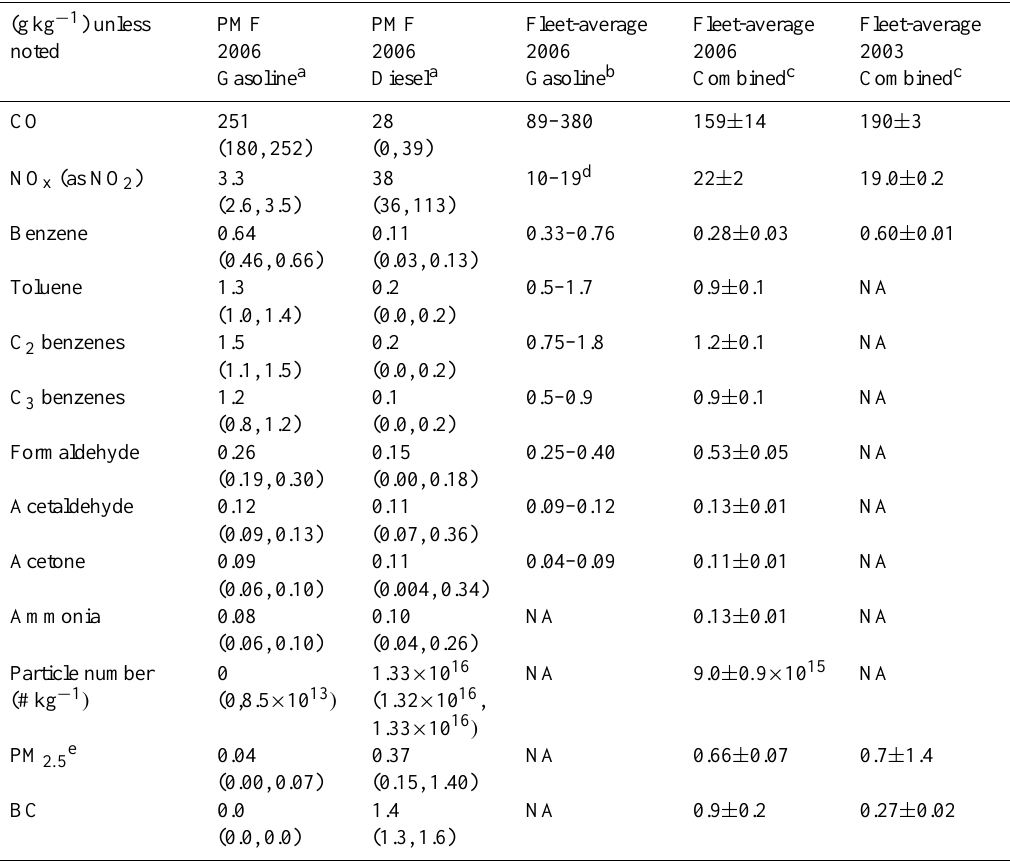
Table 3. Fuel-based emission factors in 2006 and